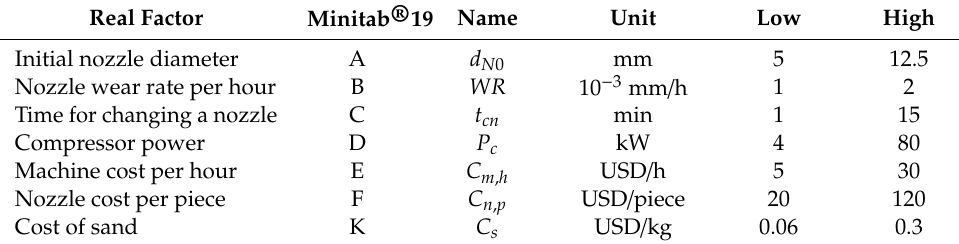
Table 1. Input parameters. Table 2. Experimental plans and output response.